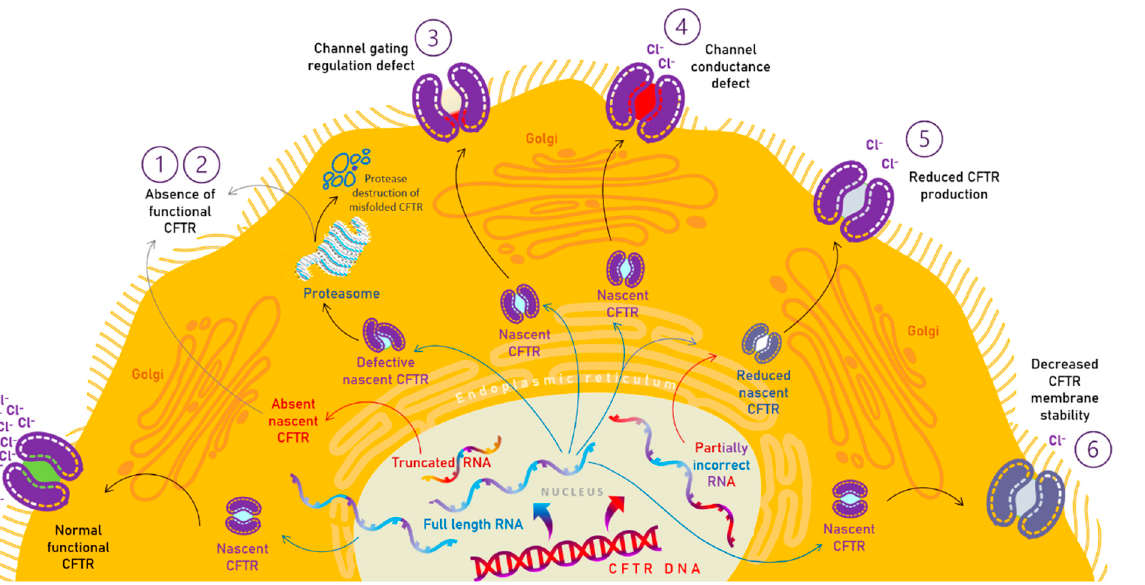
Table 2. Classes of CFTR mutations, risk of EPI and therapeutic approach (adapted from CFTR2— Clinical and Functional Translational of CFTR and McKay et al.) [4,87]. Class Type of De ‐ fect